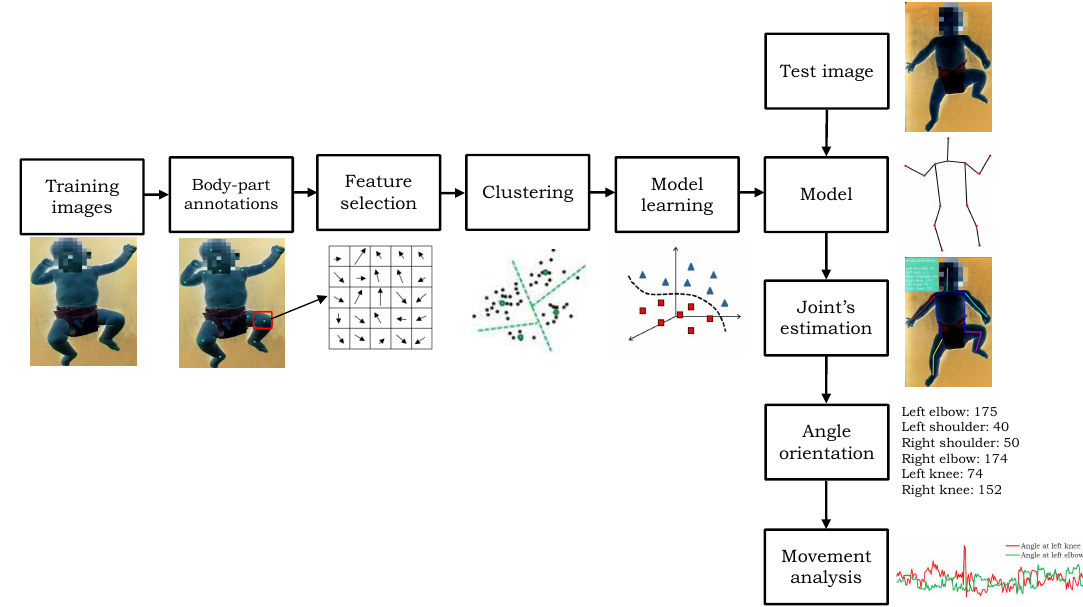
Figure 6. An illustration of model training, and the detection and the tracking of body parts. The patient body is shown in negative to preserve the privacy of the